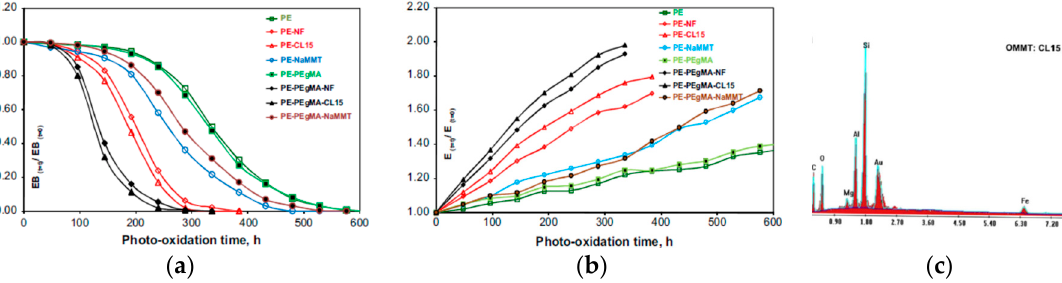
Figure 6. ( a ) Elongation at break (EB) and ( b ) Young’s modulus (E) of different samples without and with montmorillonite and compatilizing agent as a function of accelerated weathering exposure, using UV-B lamps (~313 nm). ( c ) energy dispersive X-ray analysis (EDX) of Cloisite 15A [28], Reproduced with permission from Dintcheva NTz, Polym. Degrad. Stab.; published by Elsevier, 2009. Table 4. Chemical composition of OMMT (Cloisite 15A), determined by energy dispersive X-ray